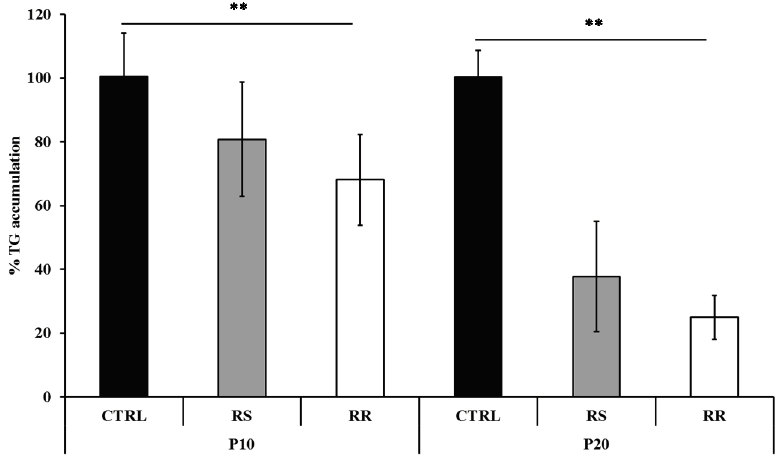
Figure 1. Effects of RS and RR extracts on triglyceride accumulation during pre-adipocyte differentiation. Triglyceride accumulation of differentiating pre-adipocytes incubated for 10 d (P10) and 20 d (P20) with RS and RR extracts relative to untreated control cells (CTRL) set as 100%. Results are depicted as mean ± standard deviation (SD). Asterisks ** indicate the significant difference between treatments for p <